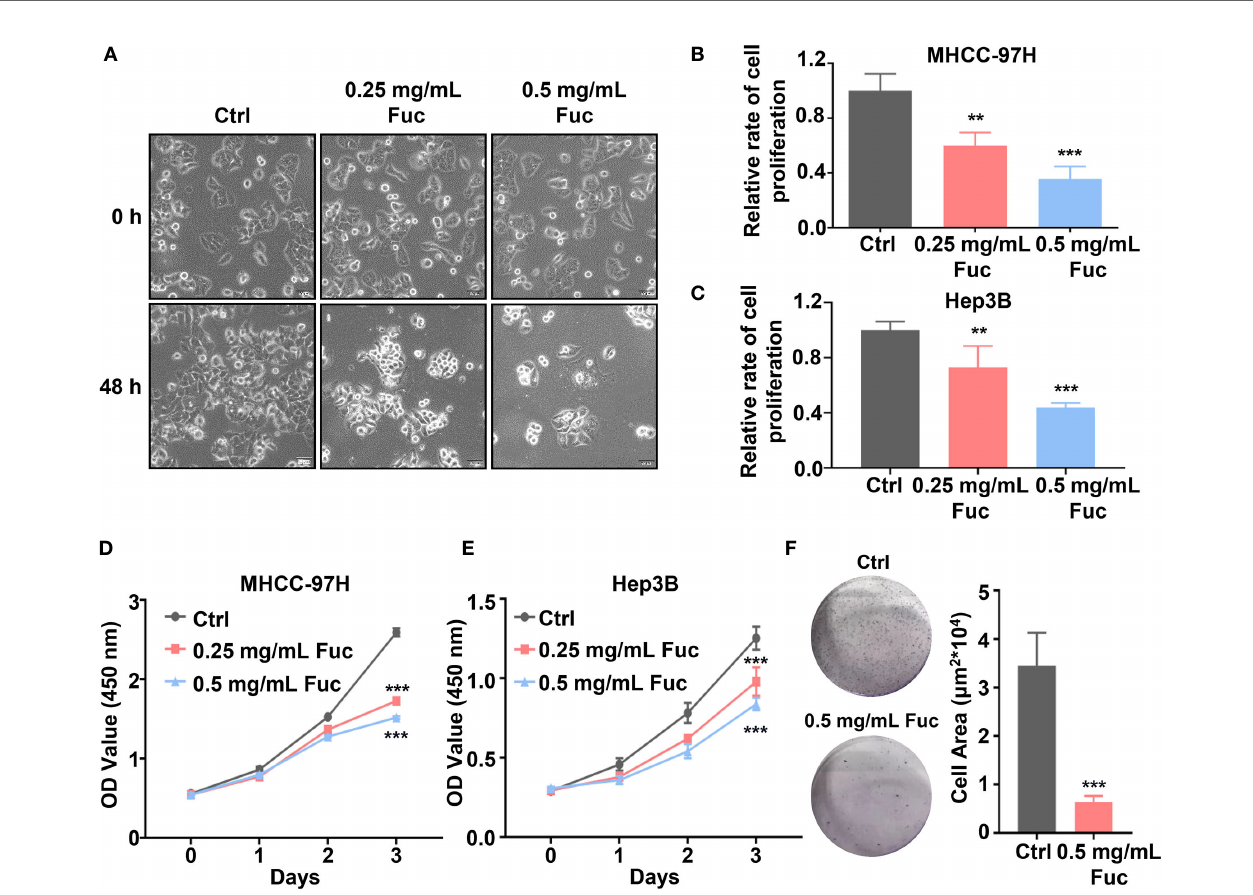
FIGURE 1 | Fucoidan inhibits proliferation of hepatocellular carcinoma in vitro . (A) Morphology of MHCC-97H cells treated with saline (Ctrl), 0.25 and 0.5 mg/mL Fuc. (B, C) Relative cell proliferation rate of MHCC-97H (B) and Hep3B (C) cells after treatment with saline (Ctrl), 0.25 and 0.5 mg/mL Fuc. ** means P < 0.01, *** means P < 0.001. (D, E) Cell viability of MHCC-97H (D) and Hep3B (E) cells treated with saline (Ctrl), 0.25 and 0.5 mg/mL Fuc. *** means P < 0.001. (F) Colony formation results of MHCC-97H cells treated with saline (Ctrl) and 0.5 mg/mL Fuc. *** means P <